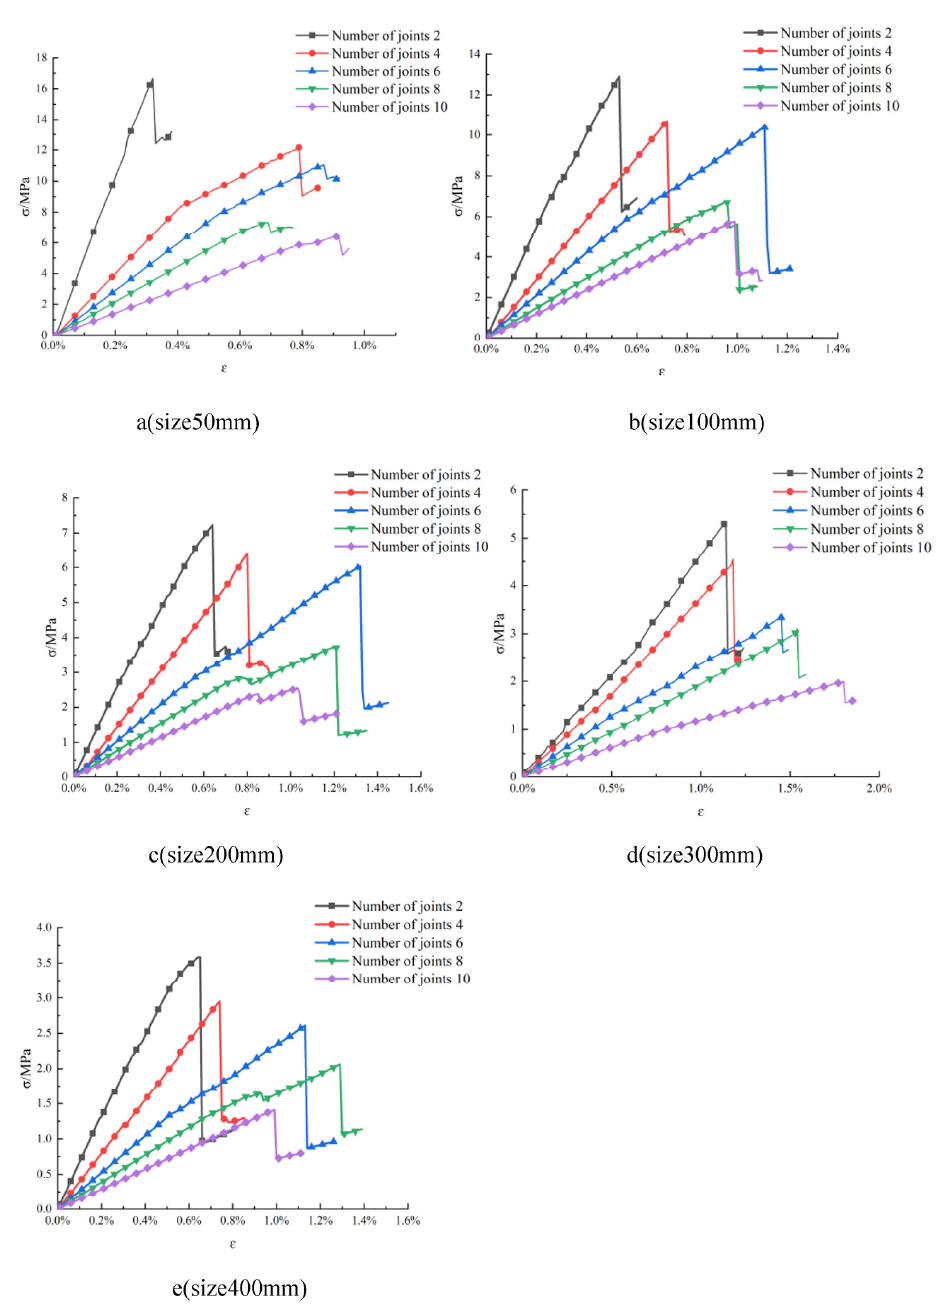
Figure 4. Stress–strain curves with different NPJs and sizes.